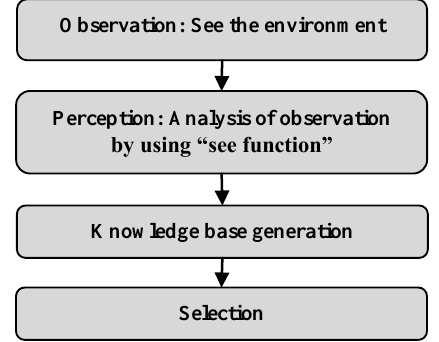
Figure 2. The process of decision making in agent